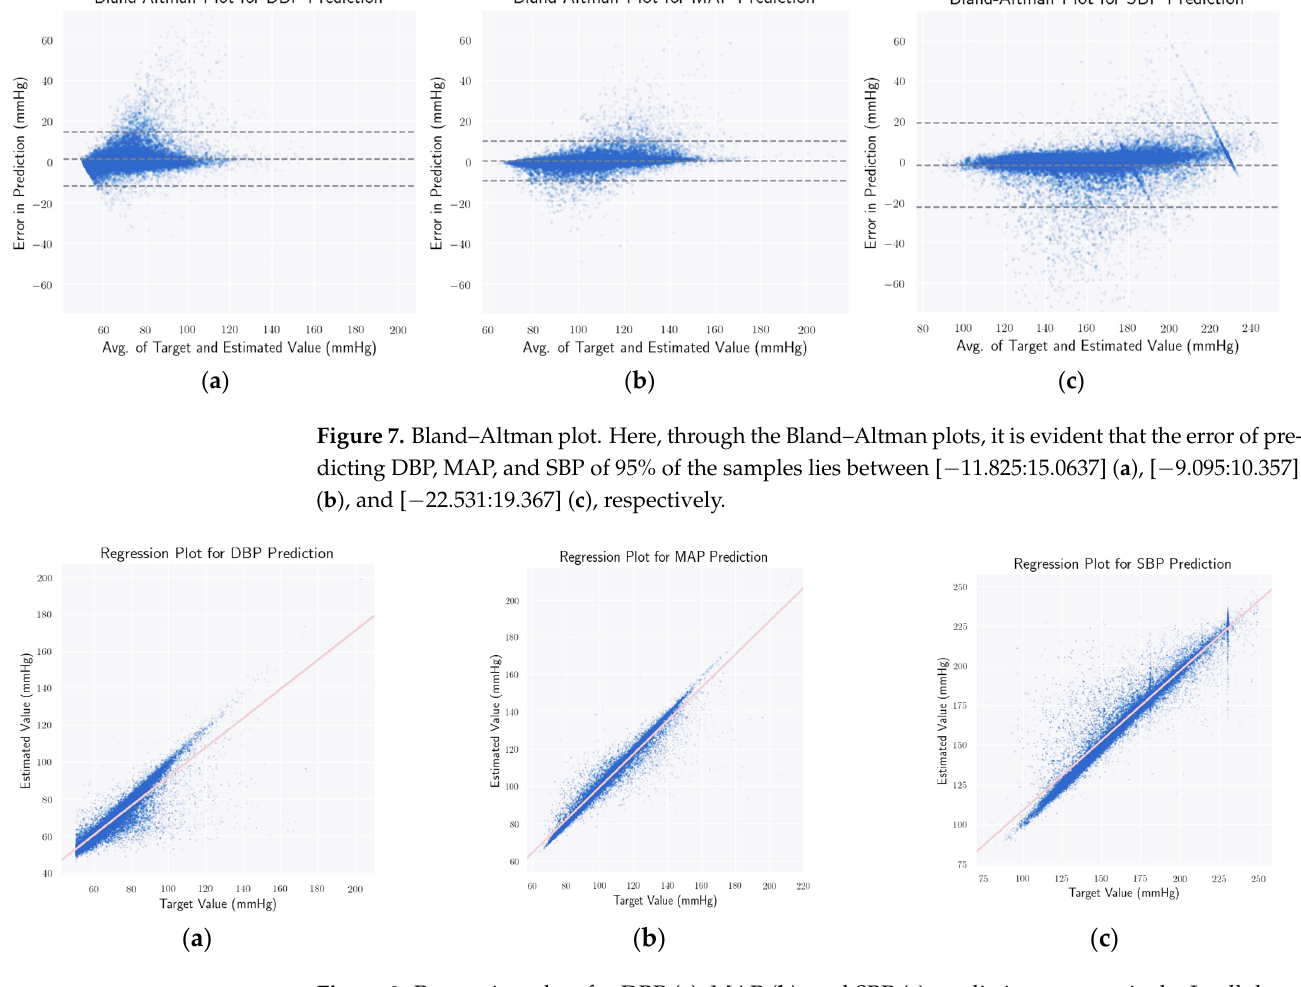
Figure 8. Regression plots for DBP ( a ), MAP ( b ), and SBP ( c ) predictions, respectively. In all three cases, we obtain a p -value in the range of p < 0.000001, which rejects the null hypothesis and strengthens the statistical significance of our method.